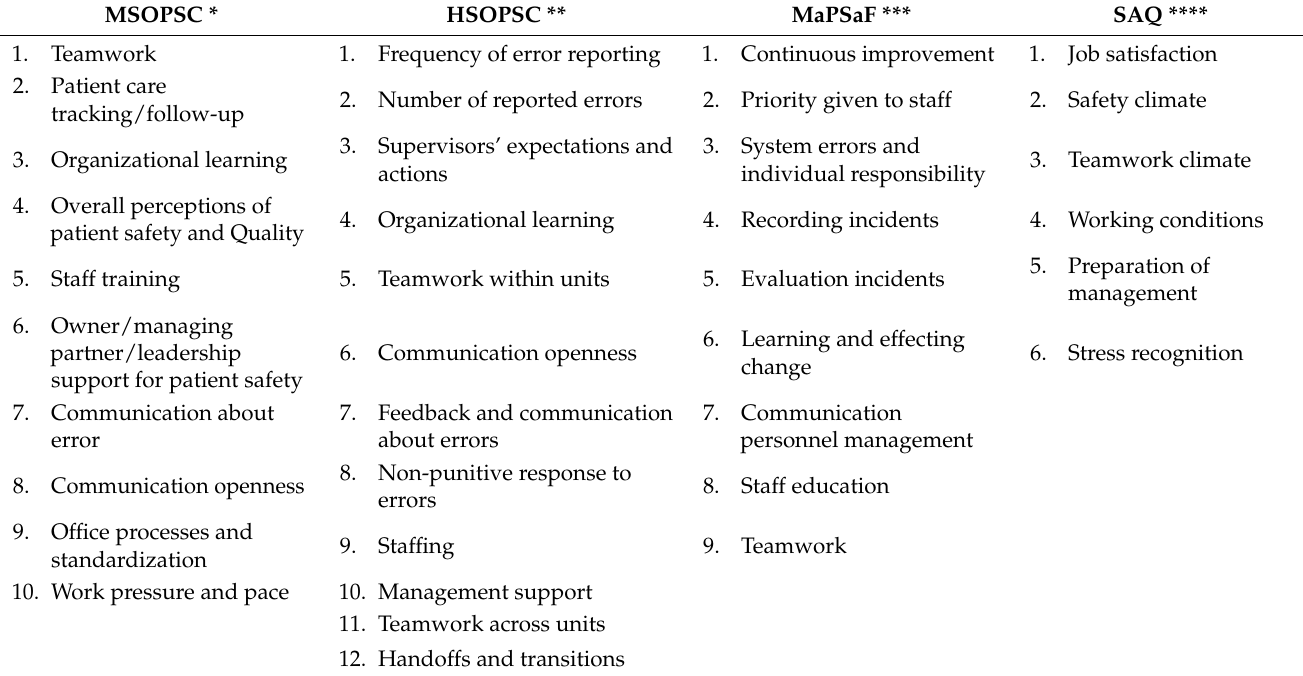
Table 1. Comparison of the safety culture dimensions measured by different survey